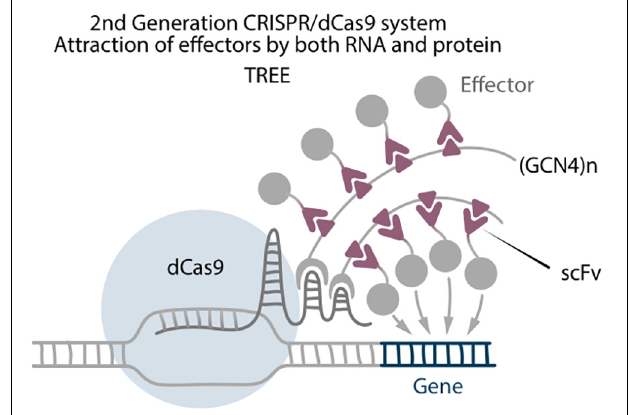
FIGURE 4 | Second generation CRISPR/dCas9 system TREE, which is a combination of Scaffold and SunTag, where (GCN4)n tail binds with RNA aptamer by MS2 RNA binding